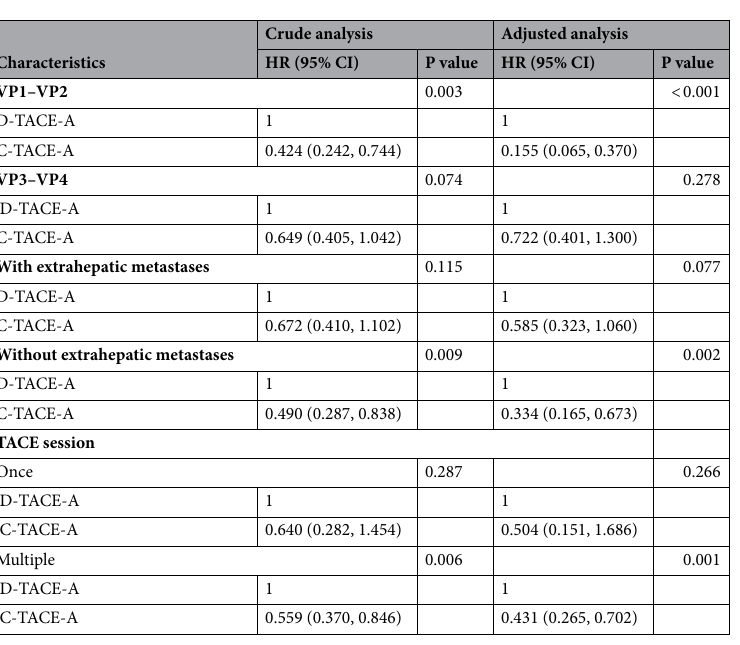
Table 6. Adjusted Cox proportional risk analysis of PFS for subgroup analysis before PSM. Adjusted for age, ALT, leukocyte, lymphocytes, platelet, tumor size, gender, HBV infection, cirrhosis, tumor number, AFP level, Child–Pugh,